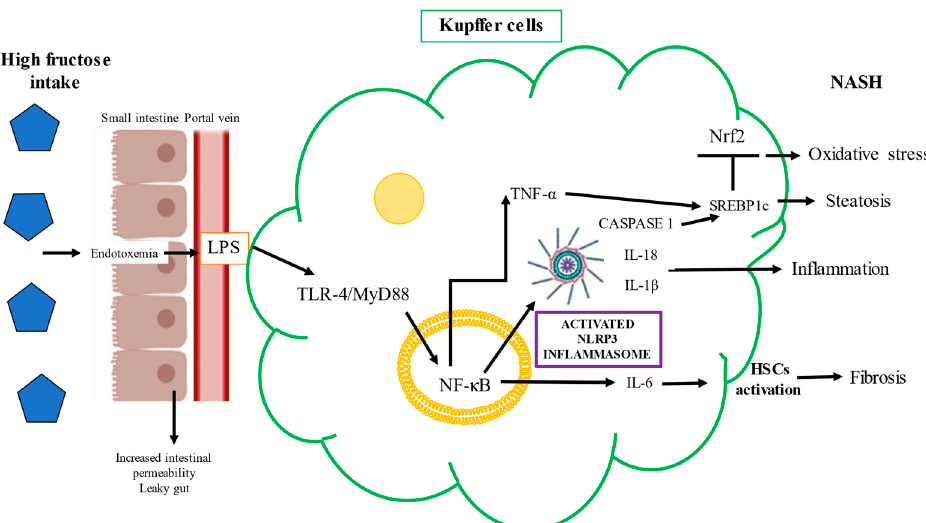
Figure 4. Molecular mechanisms by which fructose induces nonalcoholic steatohepatitis. Increased intestinal permeability (“leaky gut”) and dysbiosis produced by high fructose intake promote lipopolysaccharide (LPS) translocation from the intestine to the portal blood to reach the liver. Then, LPS activates the Toll-like receptor (TLR)-4/MyD88 signaling pathway, inducing tumor necrosis factor-alpha (TNF- α ) through the nuclear translocation of transcription nuclear factor kappa B (NF- κ B), which reinforces the inflammatory process through NLRP3 inflammasome activation and the subsequent maturation of interleukin (IL)-1 beta ( β ), caspase 1, and IL-18. Additionally, TNF- α and caspase 1 promote sterol-responsive element-binding protein 1 c (SREBP1c) activation and nuclear factor E2-related factor 2 (Nrf2) inhibition, while IL-6 drives hepatic stellate cell (HSC) activation, an orchestrated interaction of various molecular factors, leading to oxidative stress, inflammation, steatosis, and fibrogenesis, which pave the way to nonalcoholic steatohepatitis (NASH) development.